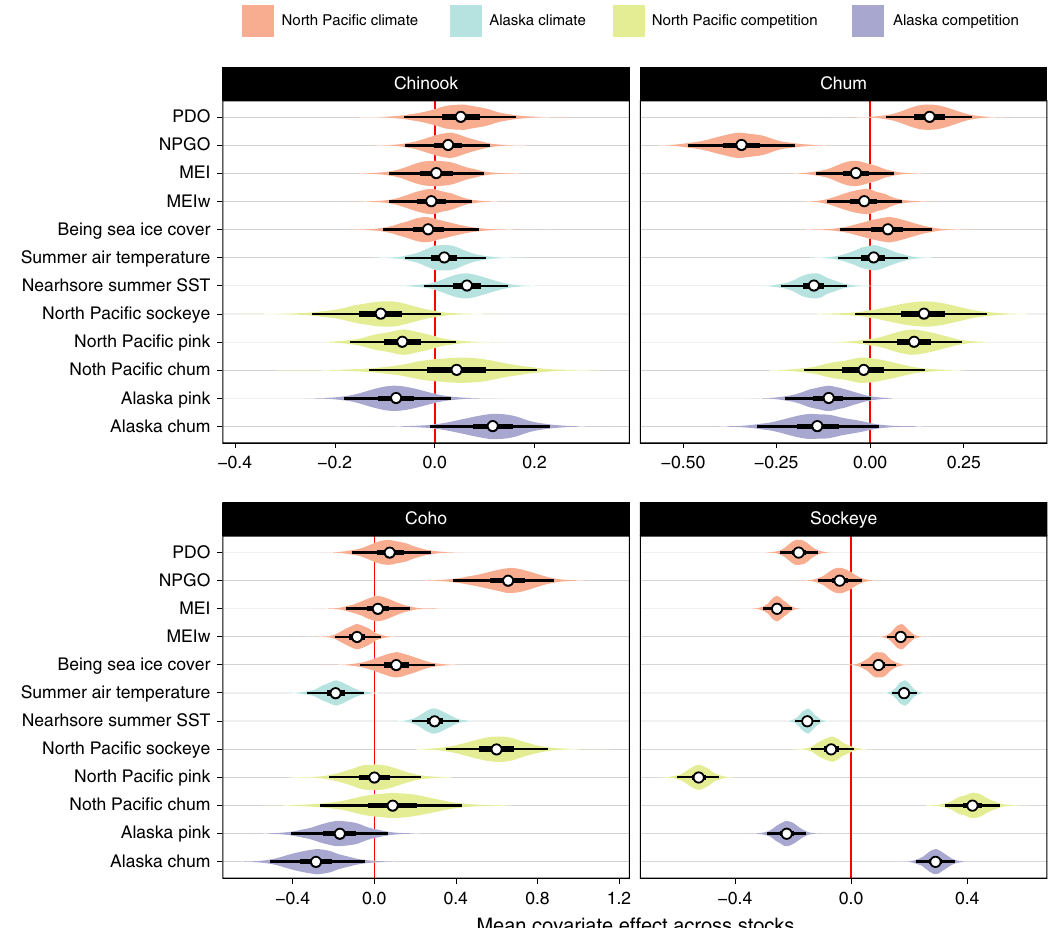
Fig. 4 Climate and competition in fl uence salmon body size. Effects of climate and competition proxies (detailed in Methods, MEIw is winter MEI) on body size varied among species, as estimated by hierarchical Bayesian models describing length-environment relationships. Posterior probability distributions (in color) for estimated species-speci fi c (group) mean effects of climate and competition covariates across locations. Posterior medians, 50% and 95% credible intervals are described by the white point, thick and thin black lines. Negative effects indicate high values of a covariate are correlated with smaller salmon body size on average across locations in Alaska. See Supplementary Fig. S4 for population-speci fi c covariate effect estimates. Sample sizes are presented in Supplementary Data